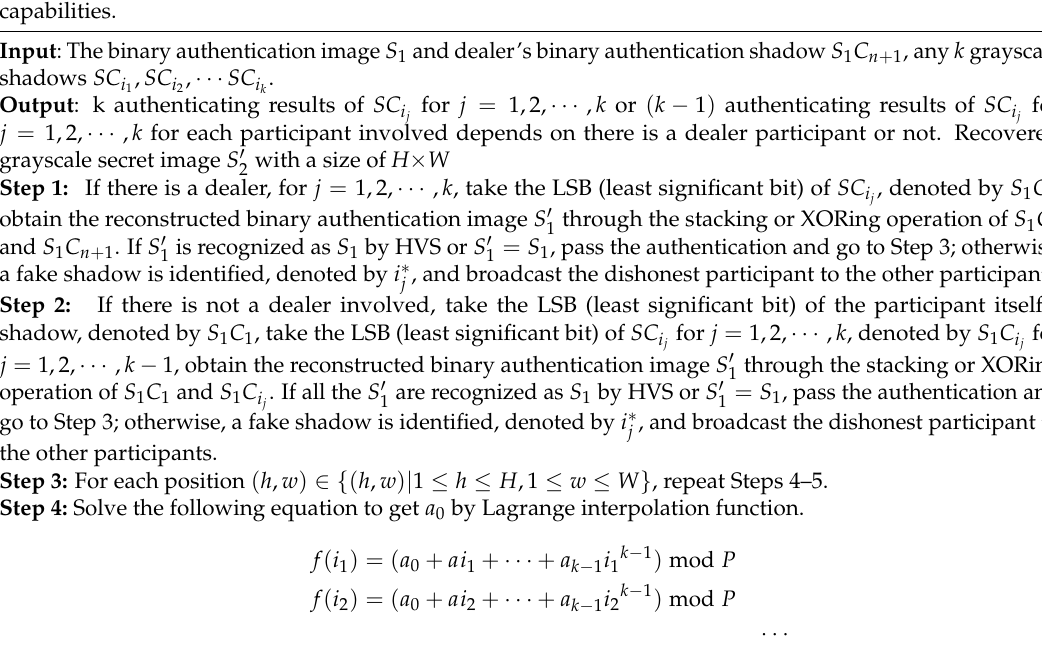
Algorithm 3 The authentication and recovery in the proposed secret image sharing for ( k , n ) threshold authentication with dealer-participatory and non-dealer-participatory mutual shadow authentication